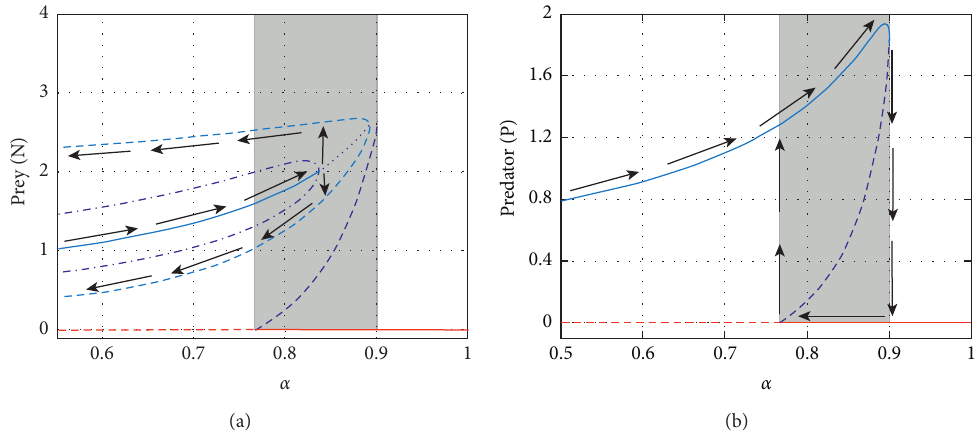
Figure 7: Evidence of hysteresis phenomenon. Using the black arrows, we show how the predator biomass is either trapped in a high amplitude limit cycle through the subcritical Hopf bifurcation (a) or exhibits a hysteresis loop (b). In (a), we take k � 0 . 8, and in (b), k � 1 . 5. Other parameter values are taken from Figure 6. Grey-shaded regions refer to the existence of multiple coexistence equilibrium points. Diagrams for prey populations are qualitatively similar.